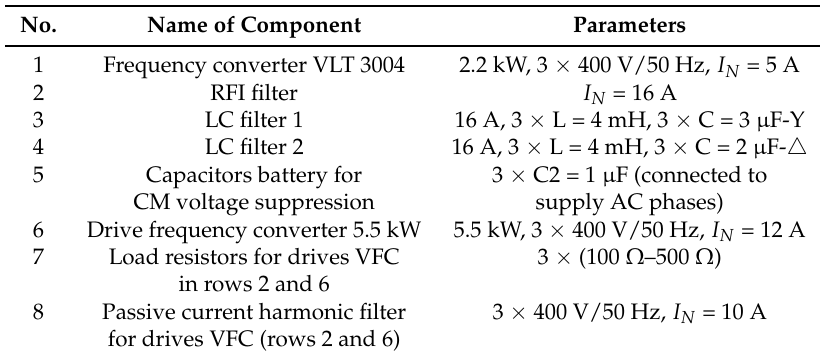
Table 1. Specification of the laboratory stand from Figure